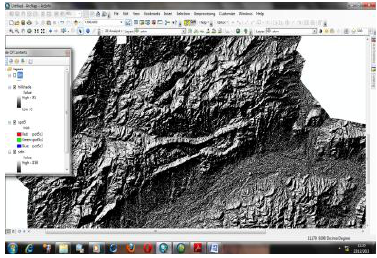
Figure 9. Shaded Relief map of the area around Dadiya Syncline 3.4 Curvature: From the output of the curvature map (fig 10), it was observed that areas with large curvature values correlates with areas where rocks outcropped on the surface which was useful in mapping areas with thick vegetation on the satellite images. Areas with low curvature values correlates with stream channels.